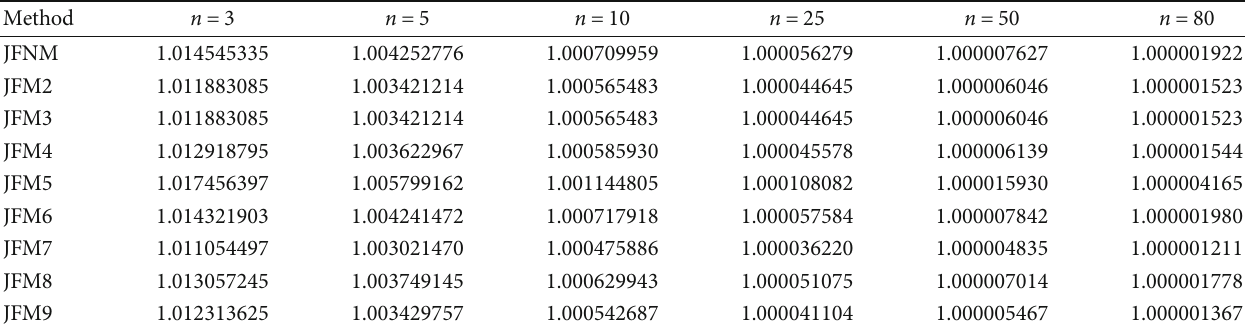
Table 29: Values of FLEI for the methods in the second category to solve Test Problem 1, and n = 3, 5, 10,25,50,80 .